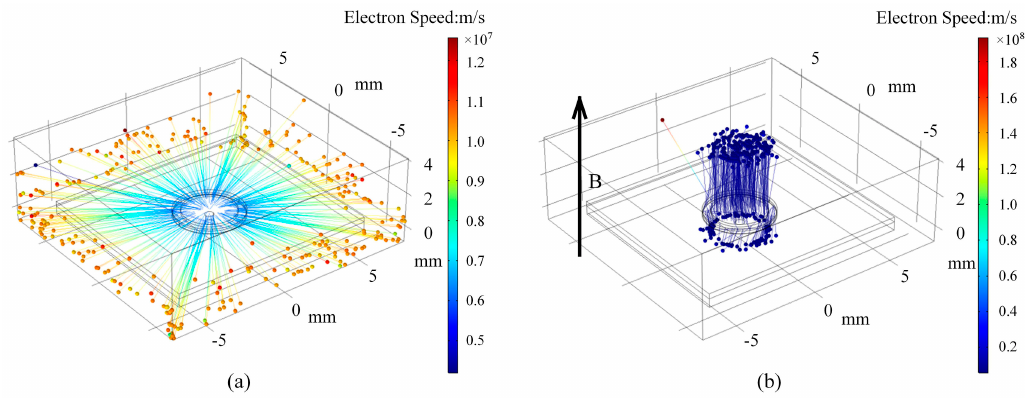
Figure 3. The simulation results of electron motion trajectory: ( a ) without a magnetic field; ( b ) with a magnetic field of B = 0.3 T.